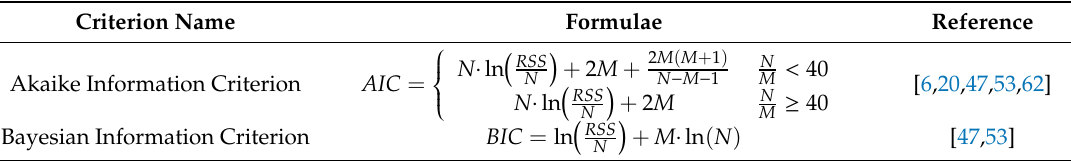
Table 4. Information criteria used in biomethane